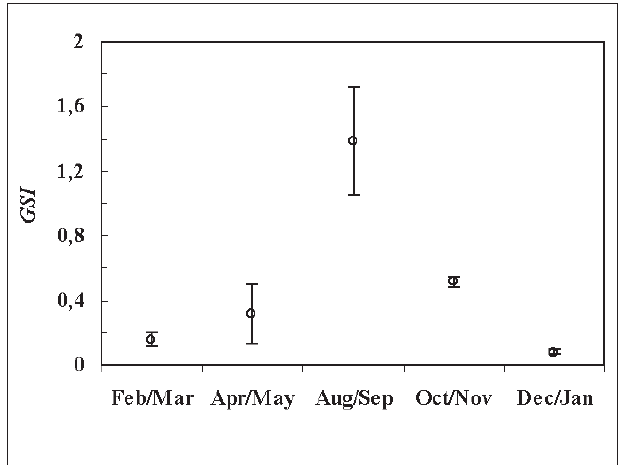
Fig. 16 . Variation of the gonadosomatic index (GSI) for females of Mycteroperca bonaci . Bar indicates standard deviation values.